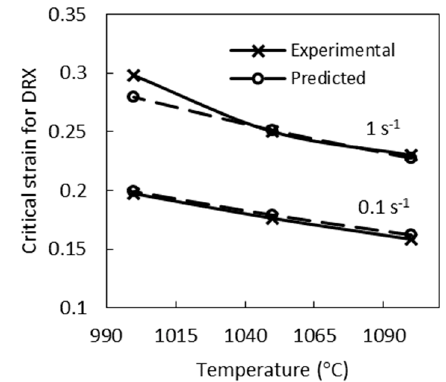
Figure 5. The dependence of the critical strain for dynamic recrystallization on the deformation temperature at a strain rate of 0.1 s − 1 and 1 s − 1 .